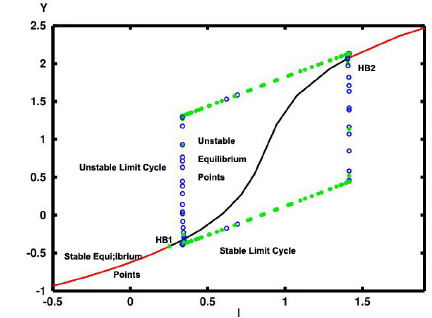
Figure 41. One-parameter bifurcation of re- covery variable concerning parameter a with parameters a = 0.8 , b = 0.7 & c = 3 . Stable (green filled circles) and unstable (blue vacant cir- cles) branches of periodic solution of the BVP model showing di ff erent dynamical behavior.